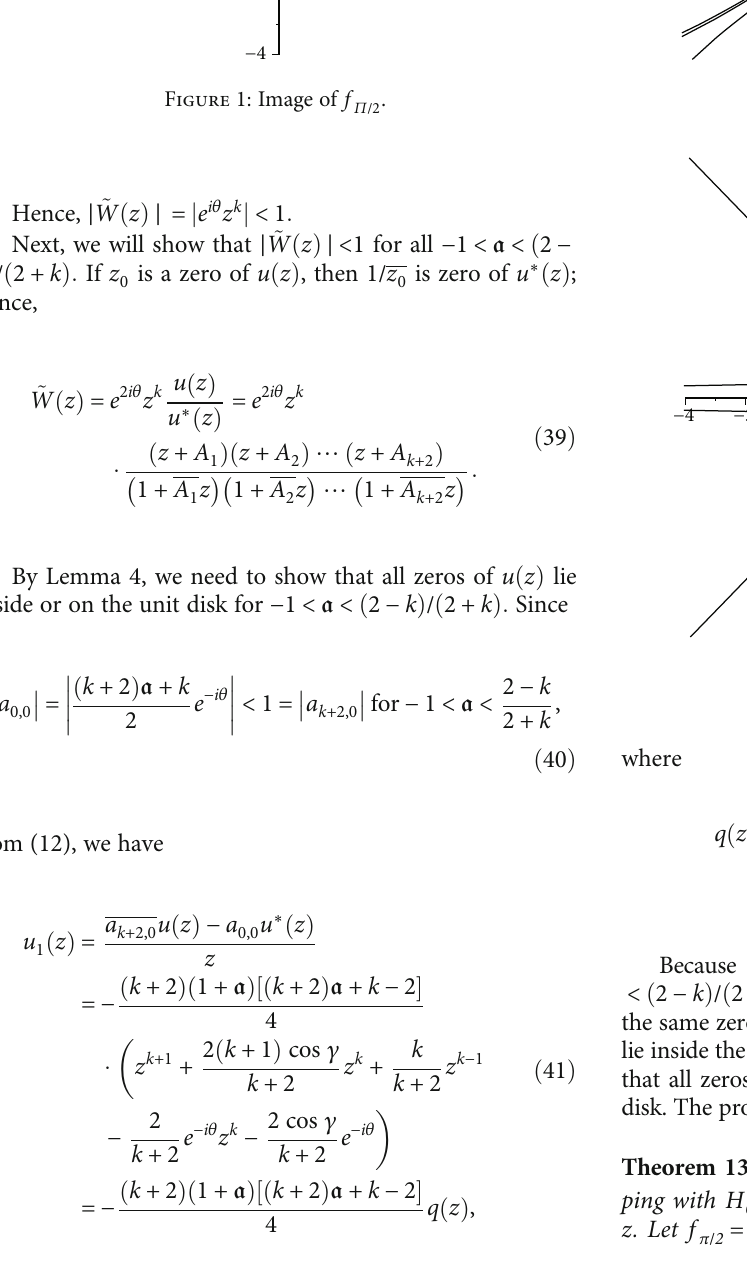
Figure 1: Image of f Π /2 . Figure 2: Image of P 2/3 .